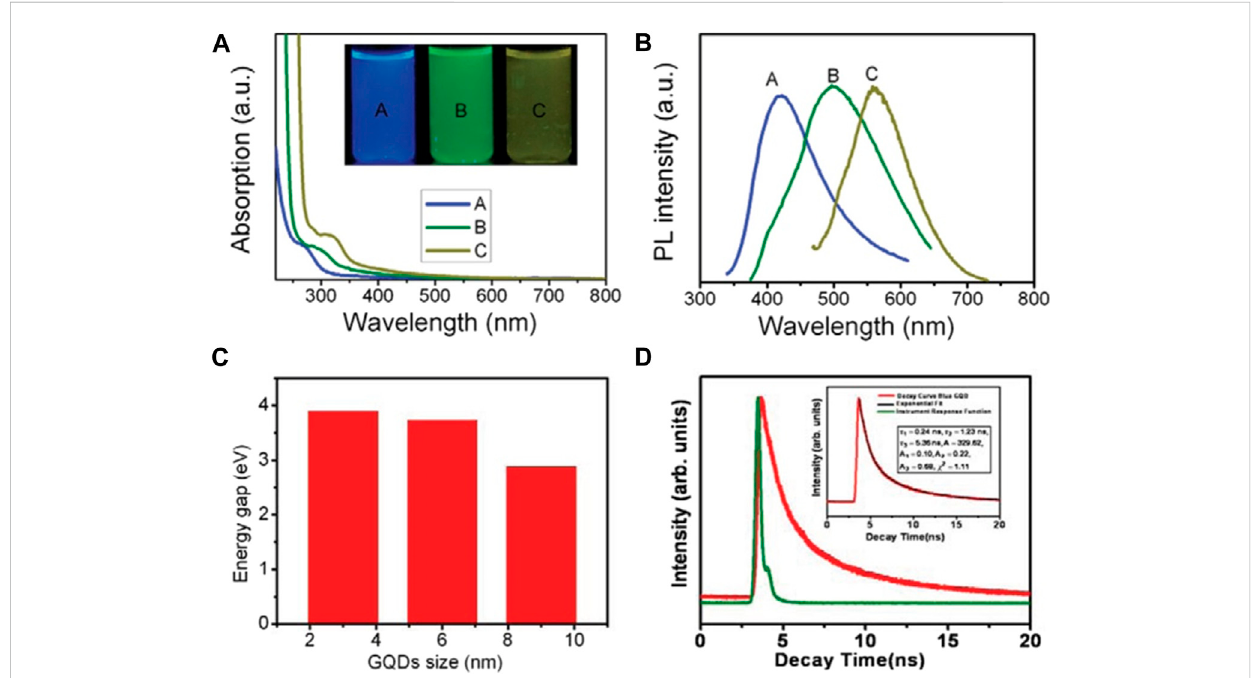
FIGURE 3 (A) UV – VisabsorptionspectraofGQDssynthesizedatvarioustemperaturesA(120 ° C),B(100 ° C),andC(80 ° C),respectively.Inset:thecorresponding GQDsunder365 nmUVlightirradiation. (B) Photoluminescentemission spectraofGQDswithdifferentemissioncolourexcitedat318,331,and429 nm, respectively. (C) Relationship between the energy gap and the size of GQDs. (D) TRPL decay pro fi le of blue GQDs. Reproduced with permission from reference (Peng et al.,